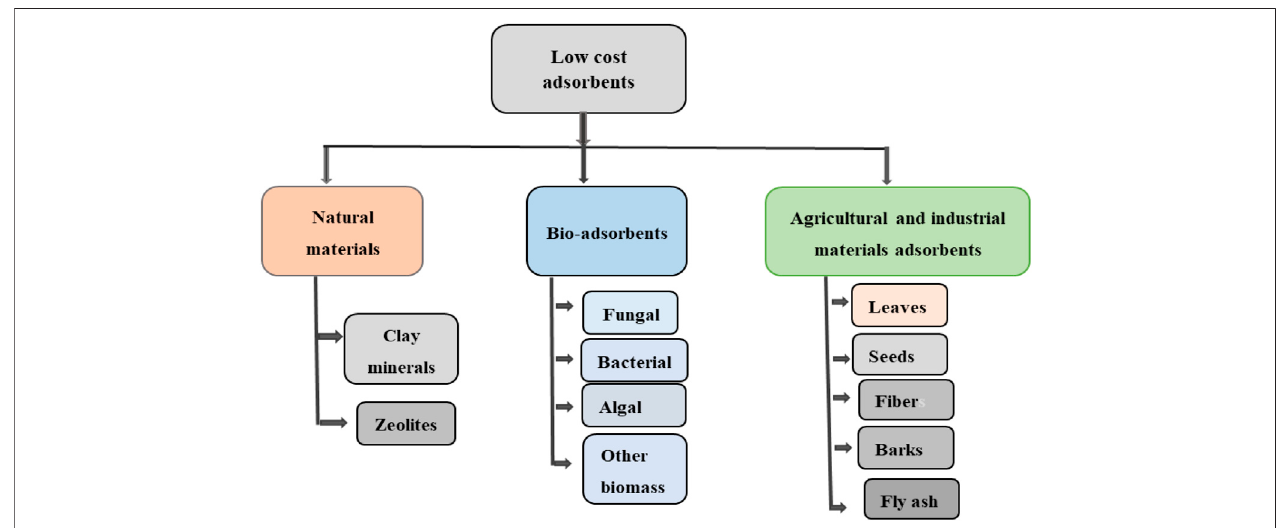
FIGURE 3 | Various low-cost adsorbents potential for dye removal: adopted with modi fi cation from Siddiqui et al. (2018).